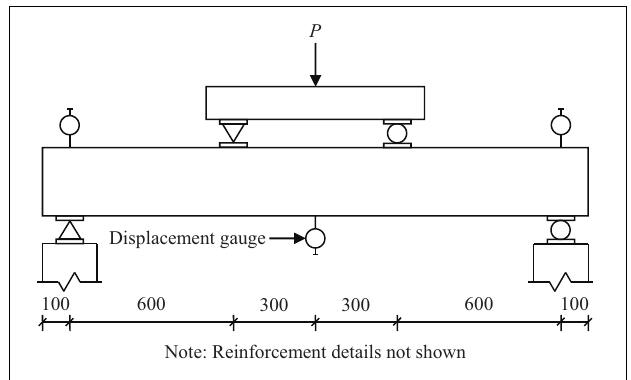
FIGURE 3 | Schematic view of flexural test (unit: